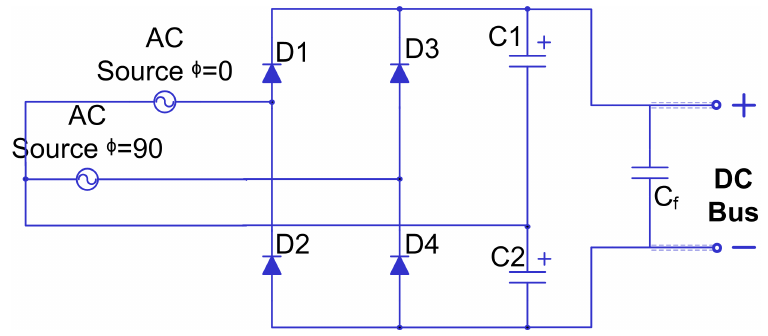
Figure 7. Cascaded voltage doubler